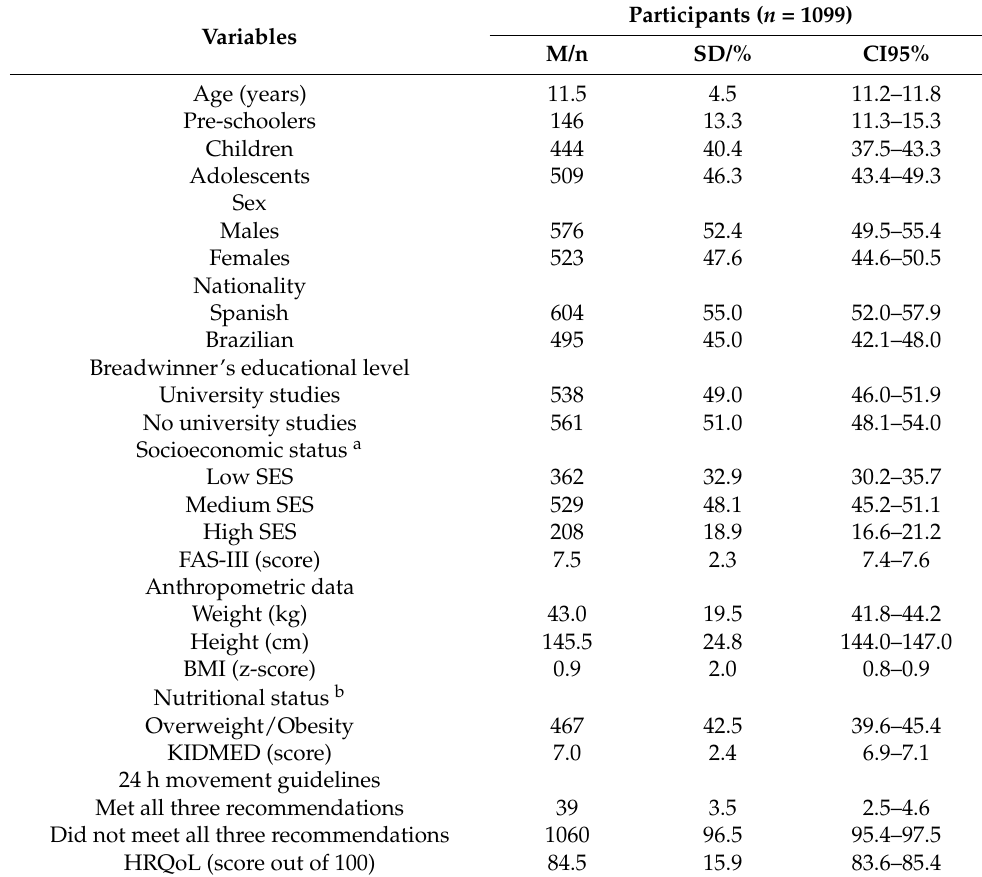
Table 1. Participant characteristics ( n =